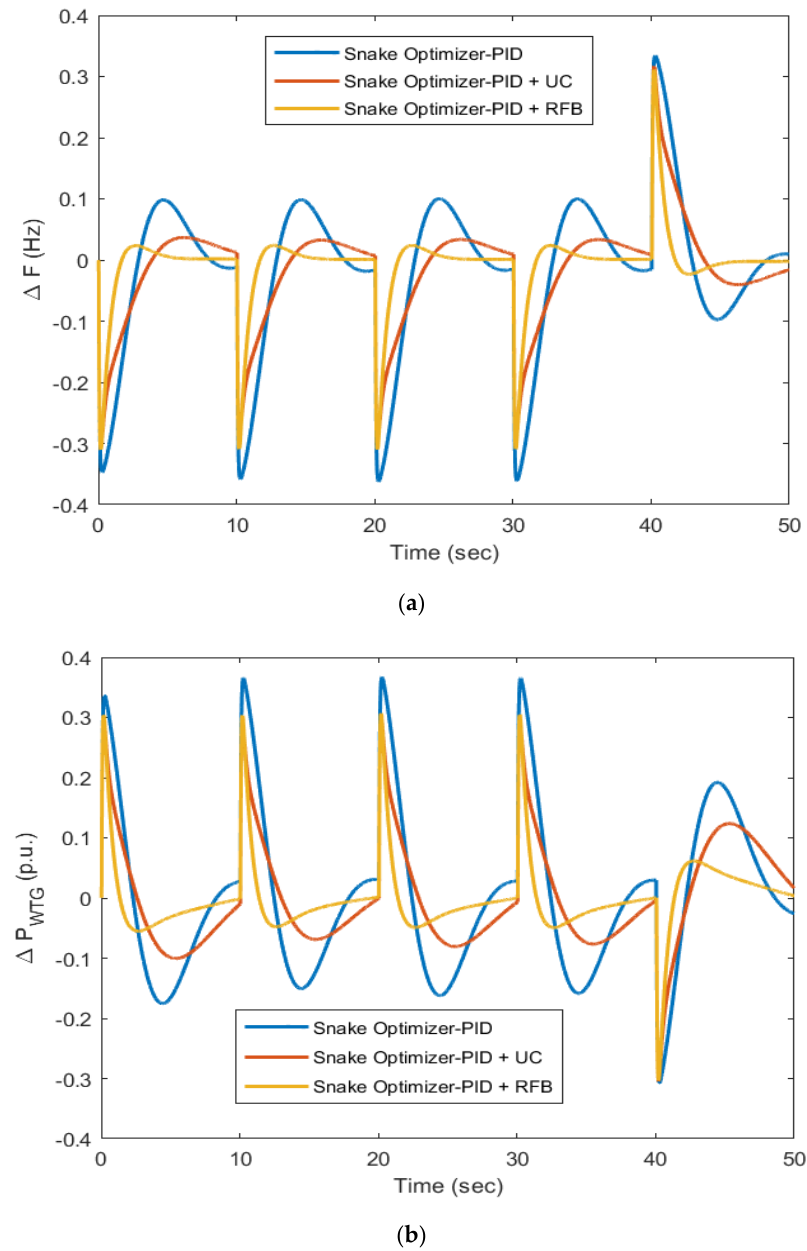
Figure 13. ( a , b ) The comparative output of PID with a UC or RFB for the diesel–wind isolated system for random load alterations.